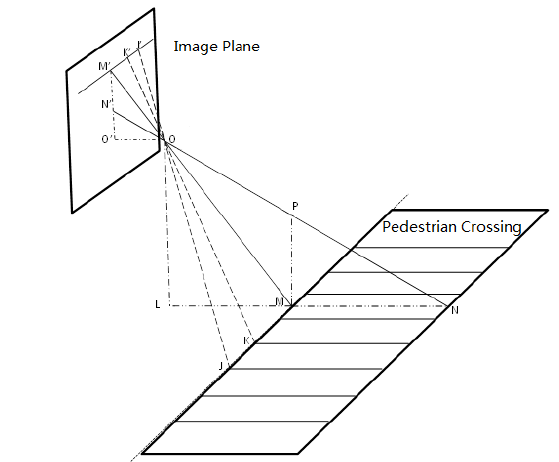
Figure 10. Auxiliary chart of photographic light